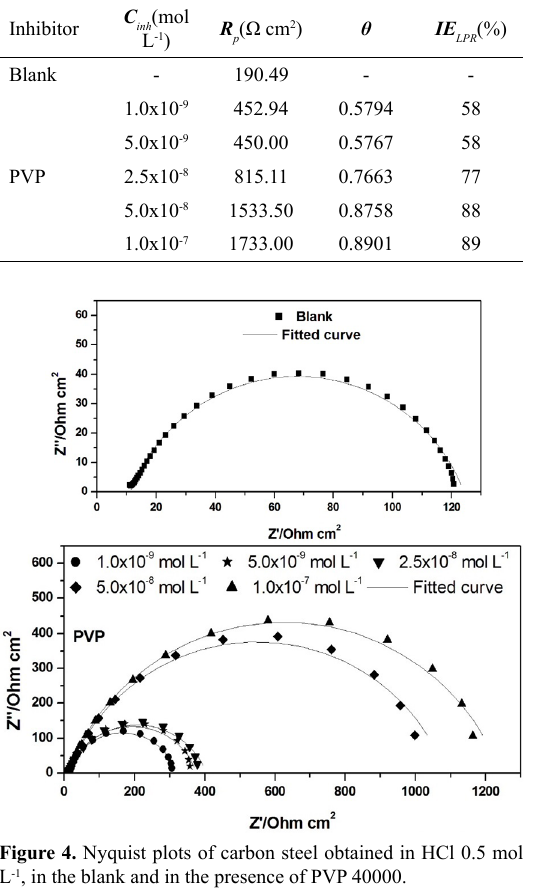
Table 2. Electrochemical parameters obtained from LPR measurements for carbon steel, in the presence and the absence of different PVP 40000 concentrations, in 0.5 mol L -1 HCl.